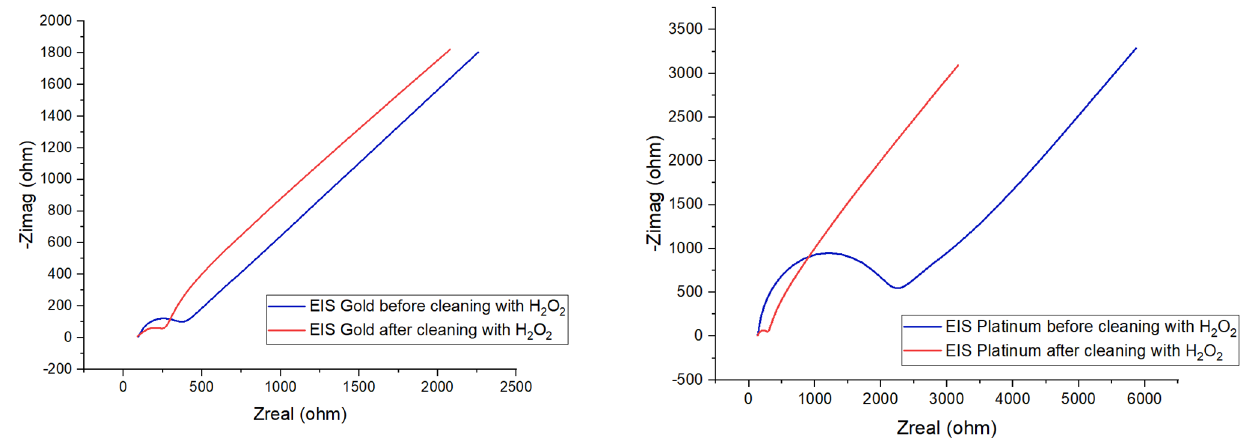
Figure 8. EIS of the gold and platinum electrodes before and after cleaning with H 2 O 2 : blue-EIS before cleaning; red-EIS after cleaning. Created with OriginPro .